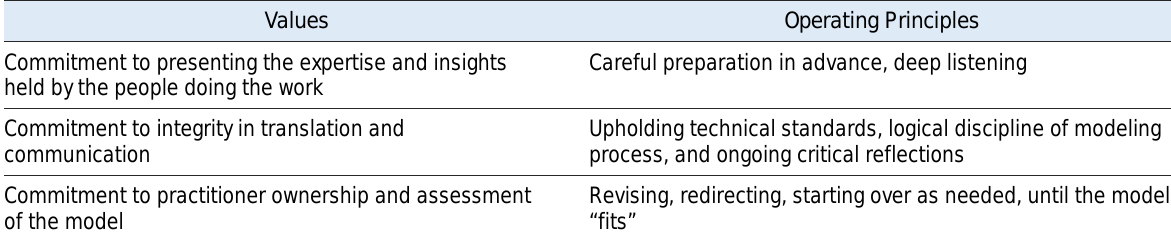
Table 2. Values and Operating Principles of Collaborative Pathway Modeling Values Operating